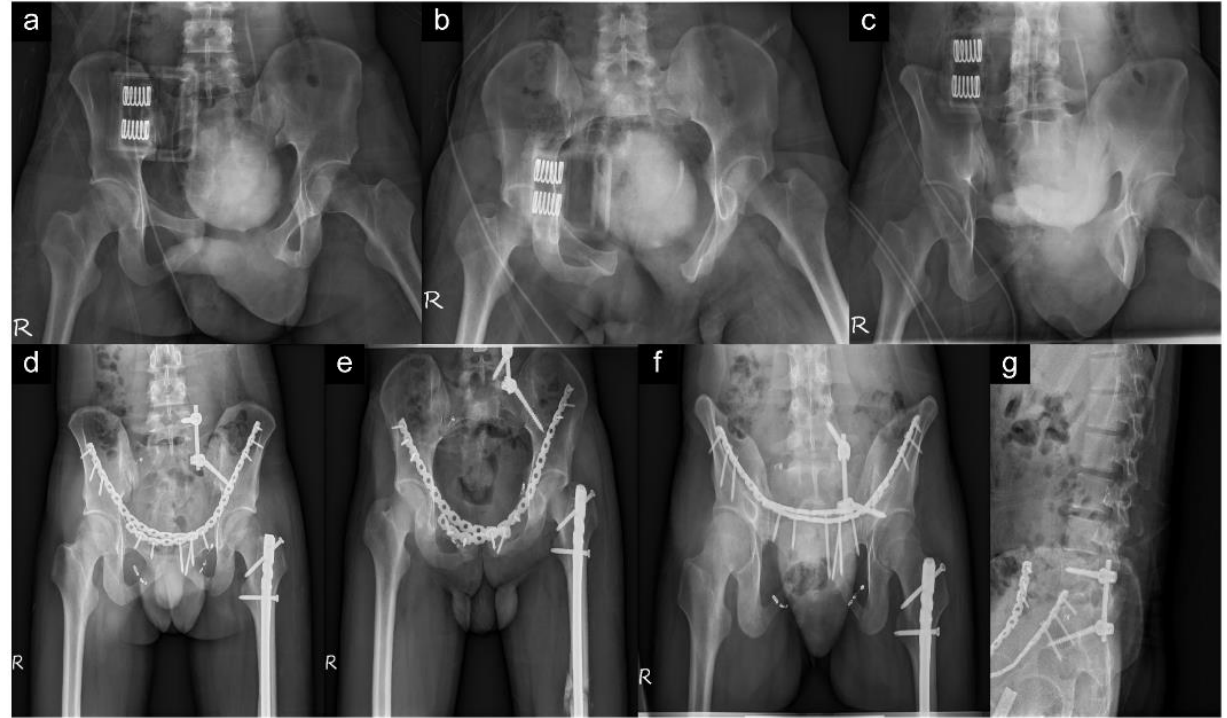
Figure 3. A 21-year-old man with anterior and posterior pelvic ring injury. The “R” on the plane radiography represents the right side of the patient. ( a – c ) Preoperative pelvic radiology series (an- teroposterior, inlet, and outlet views) showing sacral fracture, Denis zone II, left, and diastasis of pubic symphysis with right superior and inferior pubic rami and left inferior pubic ramus. ( d – f ) Postoperative pelvic radiology series (anteroposterior, inlet, and outlet views) demonstrating tradi- tional spinopelvic fixator and dual plating for anterior pelvic ring fixation. Antegrade intramedullary nailing for femoral shaft fracture (left) is also noted. ( g ) Postoperative sacral lateral view showing good position of spinopelvic fixator of the L5 and ilium.